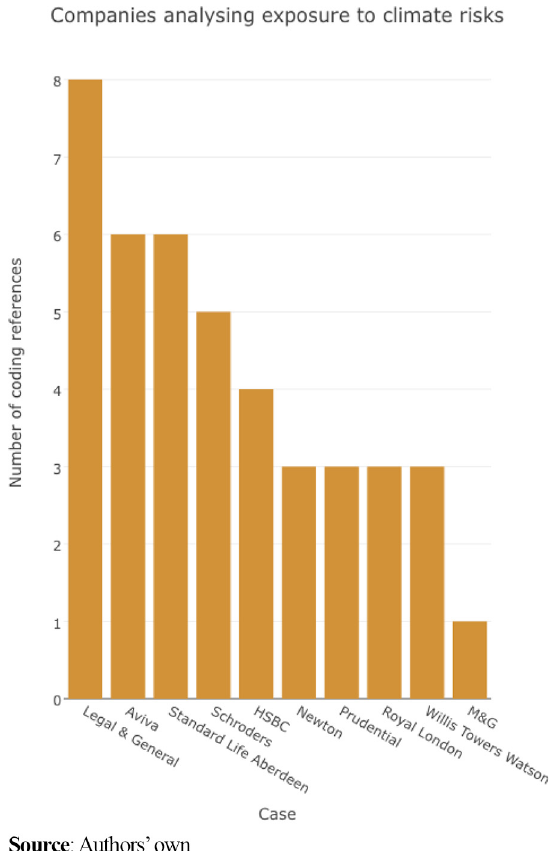
Figure 5. Number of